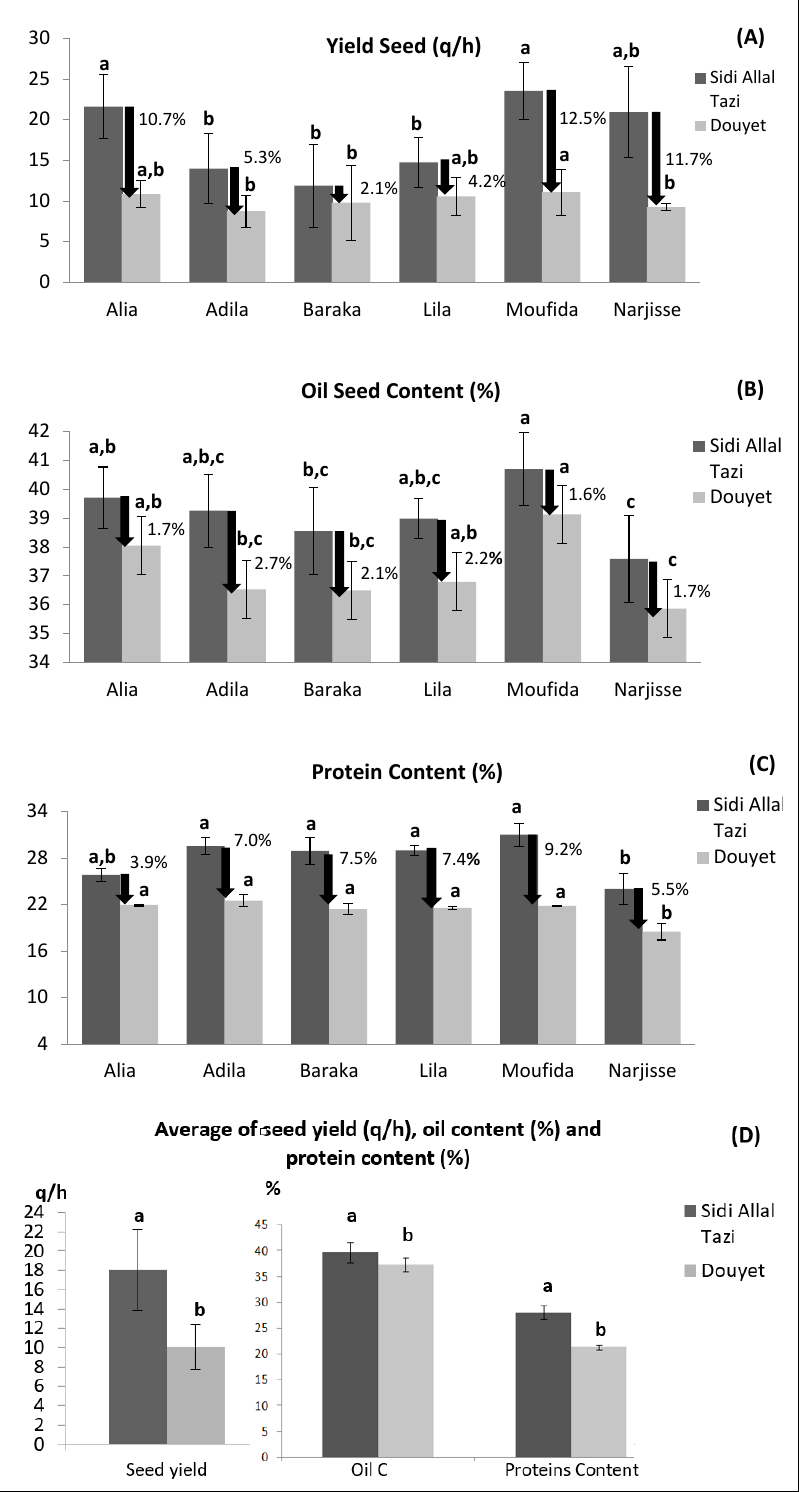
Figure 1. Seed yield (q/ha, A ), oil content (%, B ), and protein content (%, C ) variation according to the studied rapeseed varieties and their growing environments. Average values are presented along with differences observed between the two environments ( D ). In Figure 1A–C, varieties with different superscript letters, for each environment, are significantly different at p < 0.05 according to Duncan’s multiple range